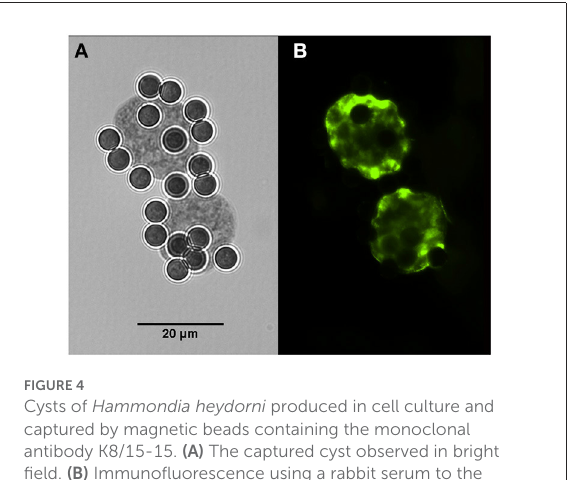
FIGURE4 Cysts of Hammondia heydorni produced in cell culture and captured by magnetic beads containing the monoclonal antibody K8/15-15. (A) The captured cyst observed in bright field. (B) Immunofluorescence using a rabbit serum to the bradyzoite antigen